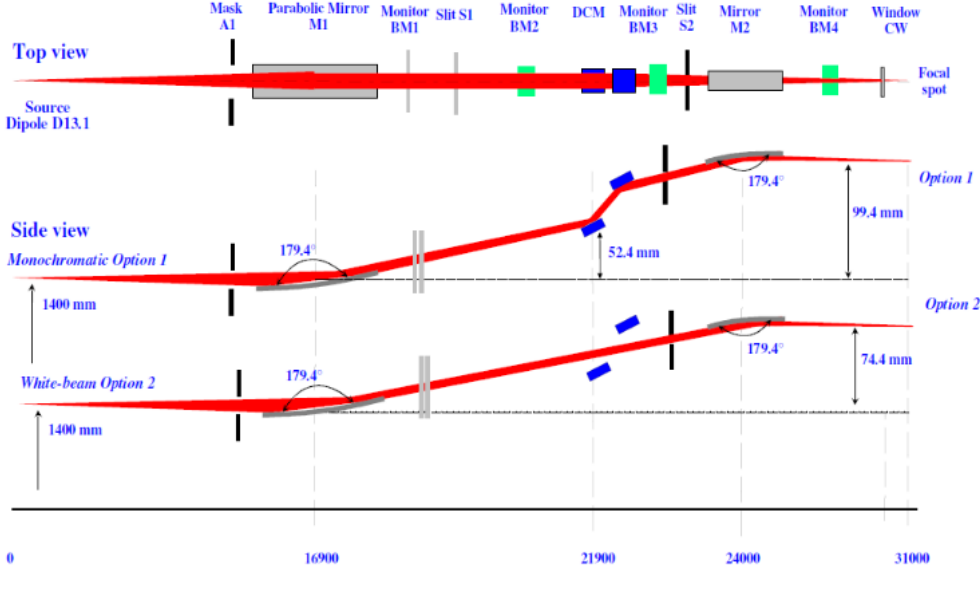
Figure 1: Optical layout of the KMC3